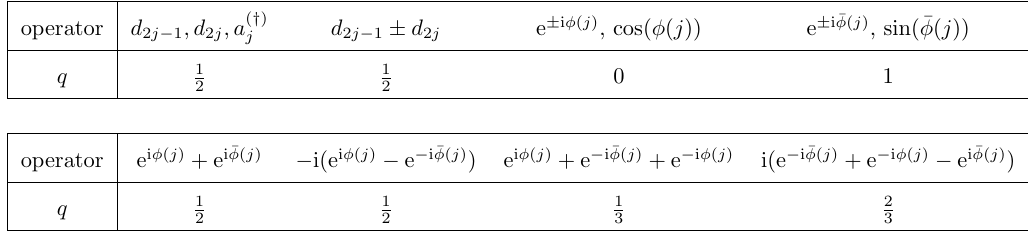
Table 2 . Some of the locally excited states we consider in critical XX spin chain. We give the operators that excite the states and the corresponding ratio of the anti-holomorphic part q . Note that there are more states we have not included in the